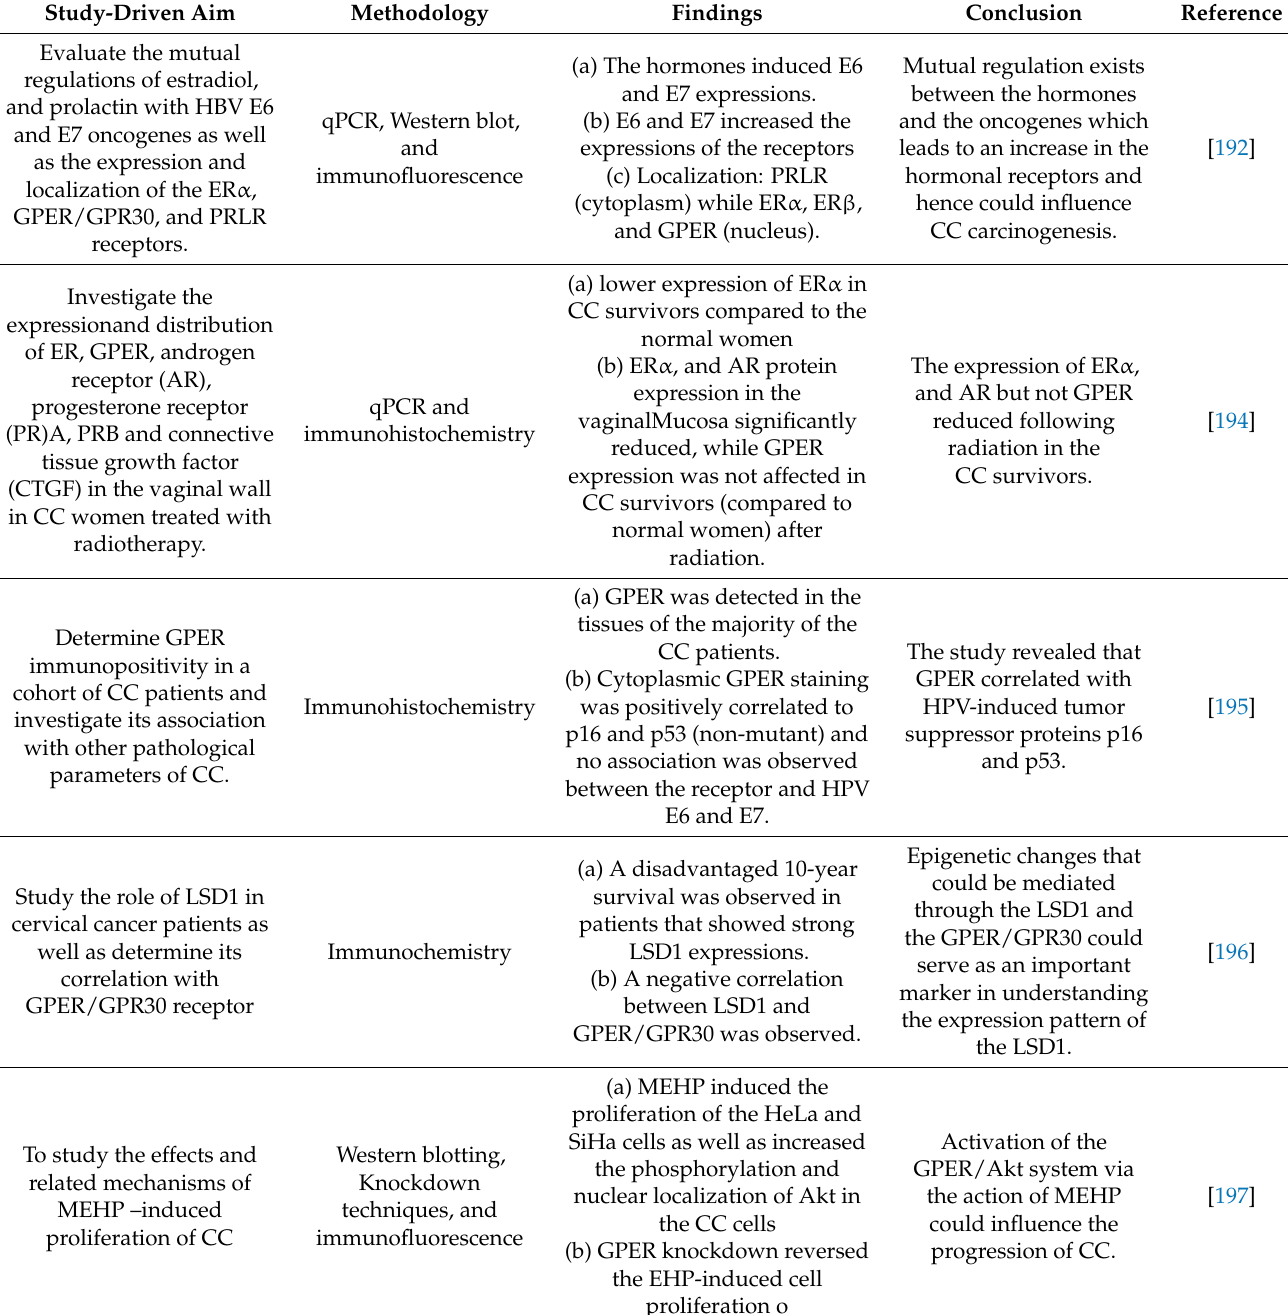
Table 3. Summary of Findings on GPER system in Cervical and Thyroid